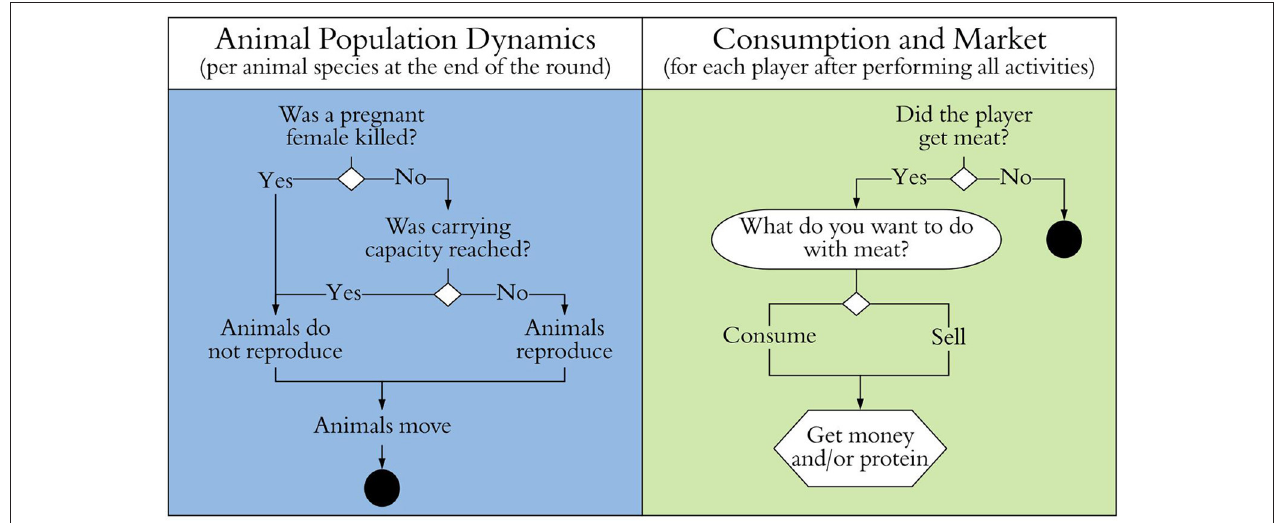
FIGURE 5 | Schematic representation of game dynamics: animal population dynamics (left, in blue) and consumption and market (right, green). The white round containers indicate questions posed to the players, the hexagonal ones are the game’s